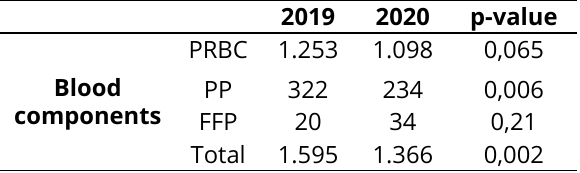
Table 1. Requests by type of blood